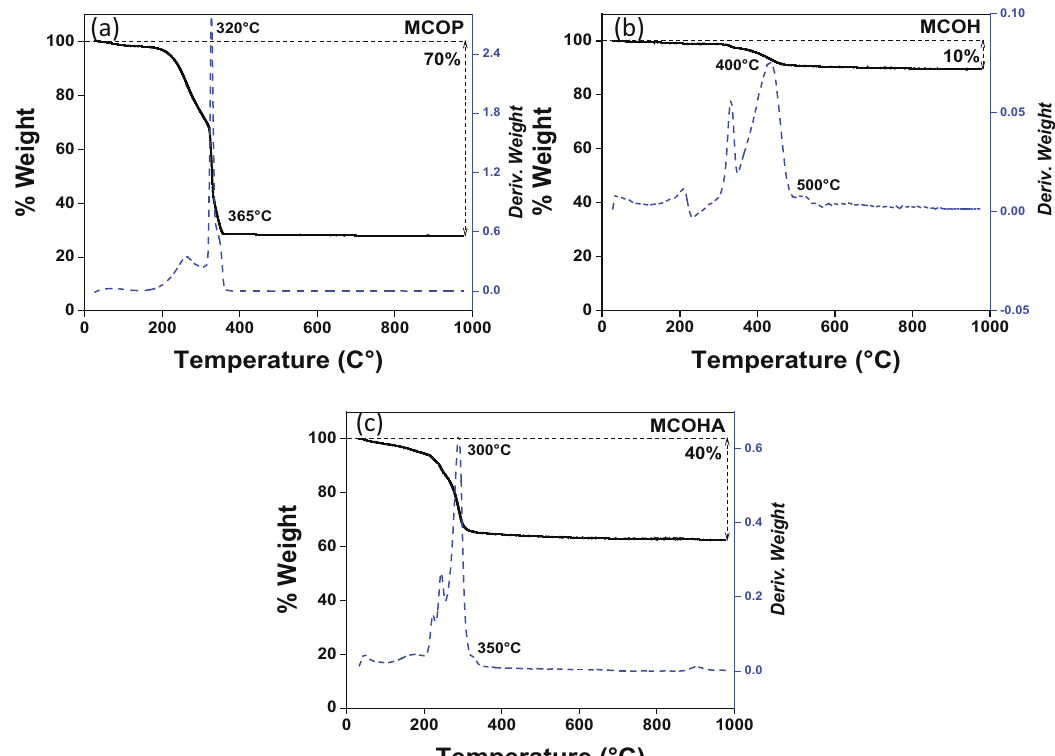
Figure 1: Thermograms of the MCO obtained by the method: ( a ) Pechini, ( b ) hydrothermal with NaOH, and ( c ) hydrothermal with